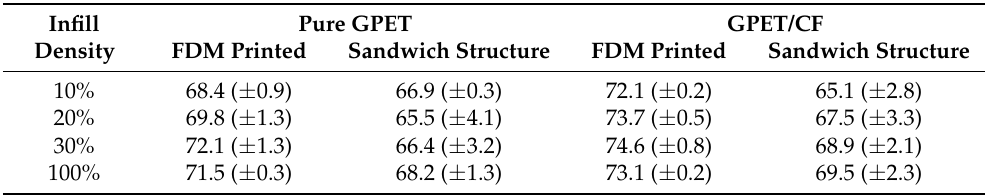
Table 1. Results of the HDT measurements for FDM-printed samples and sandwich specimens. Infill